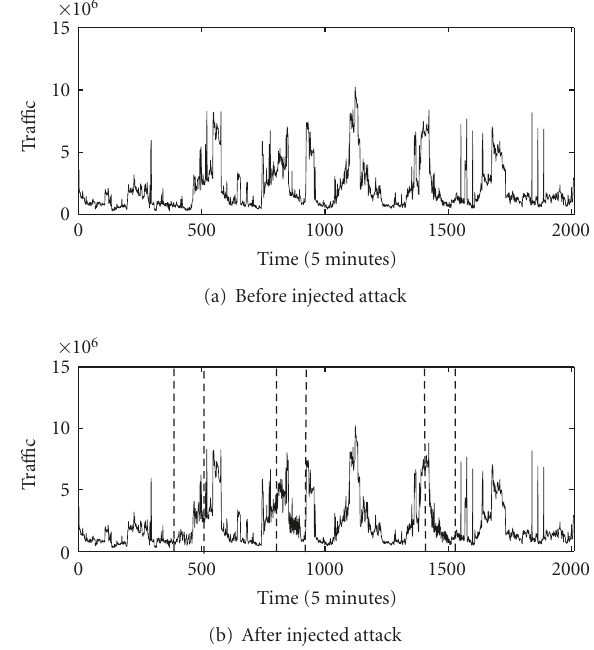
Figure 12: 124 OD flow (17th week) before and after injected periodic DDoS attacks.